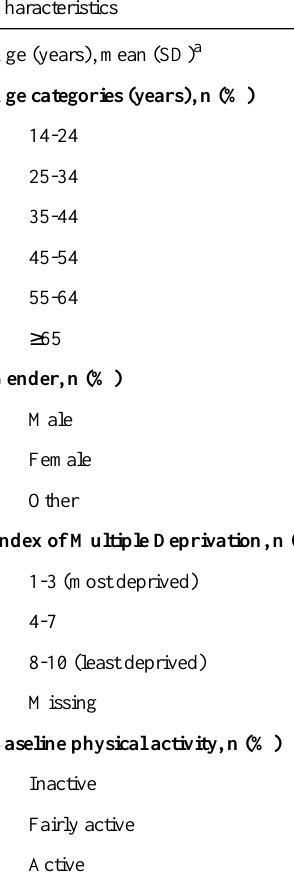
Table 2. Participant characteristics and proportions of missing data (N=5395).